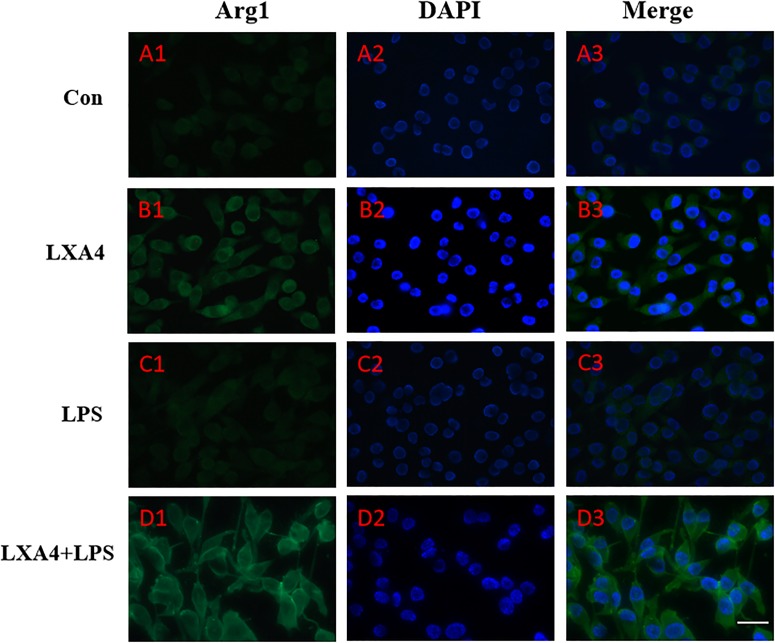
Immunofluorescence images showing the BV2 microglia after LPS stimulates which were not labeled with Arg1 antibody, with LXA4, the expression of Arg1 is expressed at high levels. Green fluorescence indicated Arg1 positive cells, while blue fluorescence indicated DAPI-labeled nuclei. Scale bar: 20 μm.